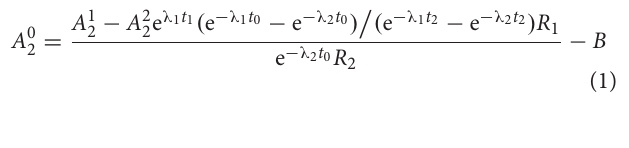
TABLE 1 | Information for sampling locations in the eastern tropical North